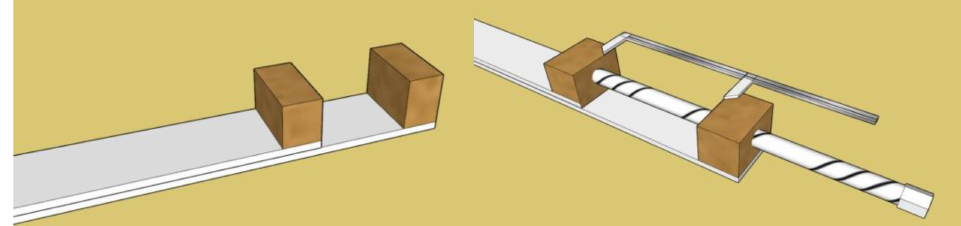
Figure 2. Graphic design of the test device from the top right, the drive part from the